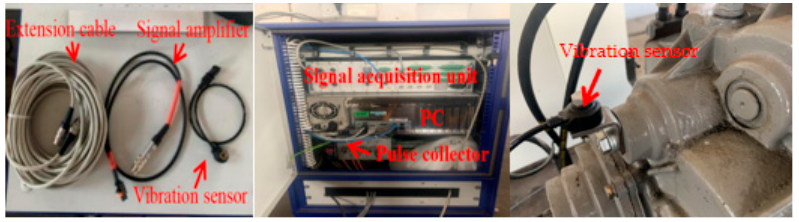
Figure 2. Signal acquisition system.